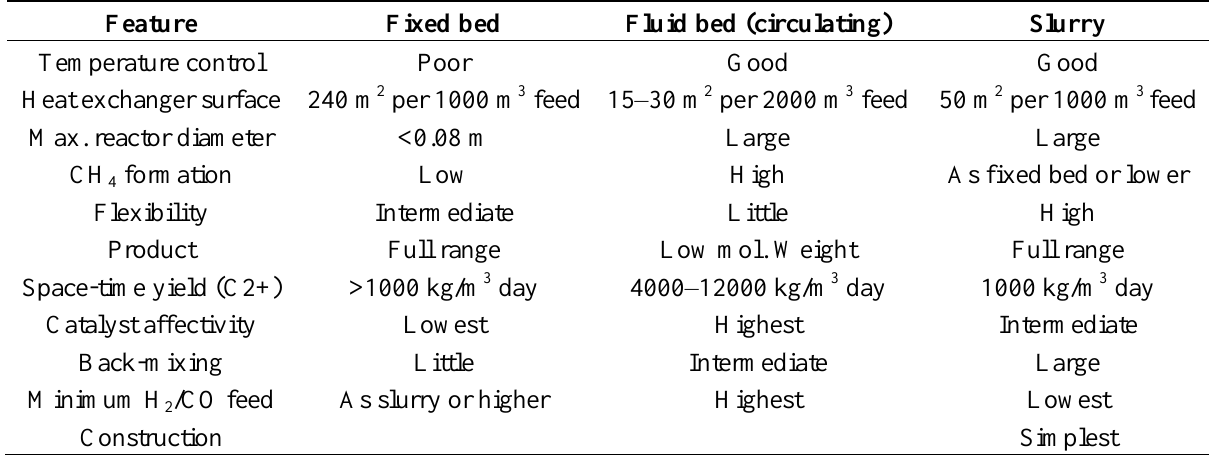
Table 5. Comparison of selected FT reactors